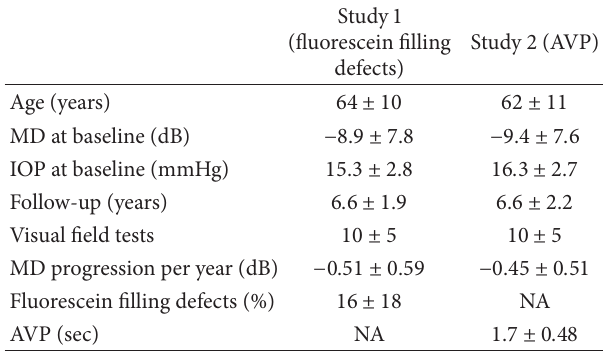
Figure 2: Bivariate plot of AVP ( 𝑃 = 0.03 , 𝑟 = −0.39 ) as a function of MD progression per year in patients with NTG. Table 1: Clinical data (mean ± SD) of patients with NTG in study 1 (fluorescein filling defects, 𝑛 = 44 ) and study 2 (AVP, 𝑛 = 28 ) with corresponding fluorescein angiographic blood flow parameters.